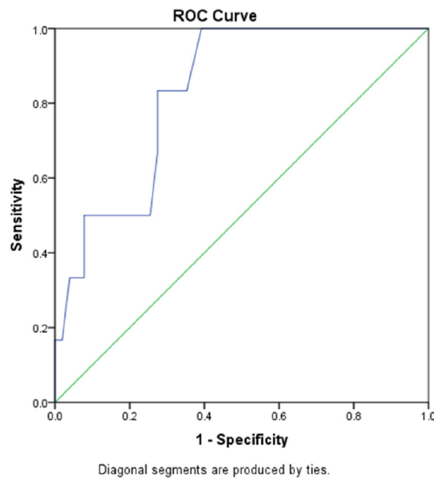
Figure 5. Analysis of the effect of the resected metastases dimension on oncologic outcome.